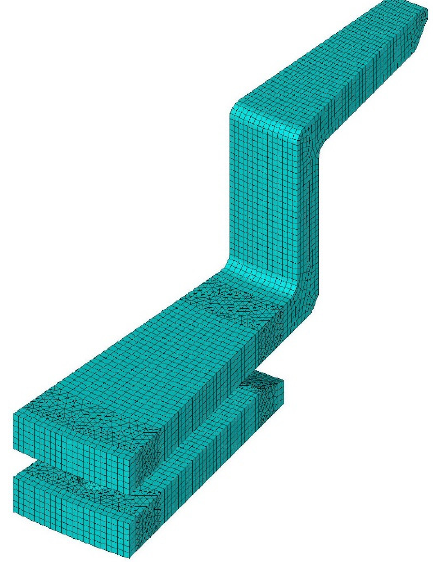
Figure 13. Finite element grid of the sliced rotor model.